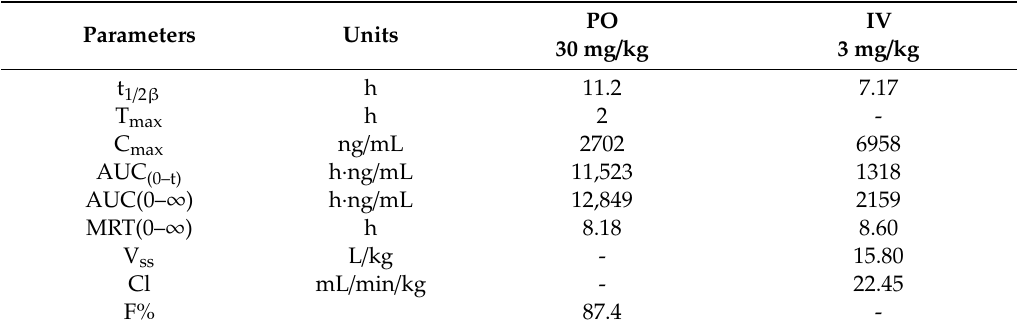
Figure 3. Mean plasma concentration-time profile in male C57BL / 6 mice after administration of a single oral (30 mg / kg) and intravenous (3 mg / kg) dose of compound i12 . PO stands for oral administration of drug; IV stands for intravenous administration of drug. Table 3. Pharmacokinetic parameters of compound i12 after a single oral or intravenous dose in male C57BL / 6 mice.